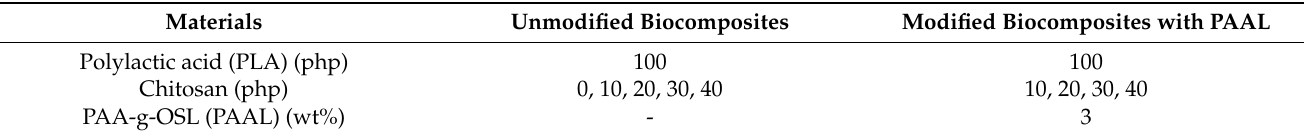
Table 2. Formulation of unmodified and modified PLA biocomposites at different chitosan contents.